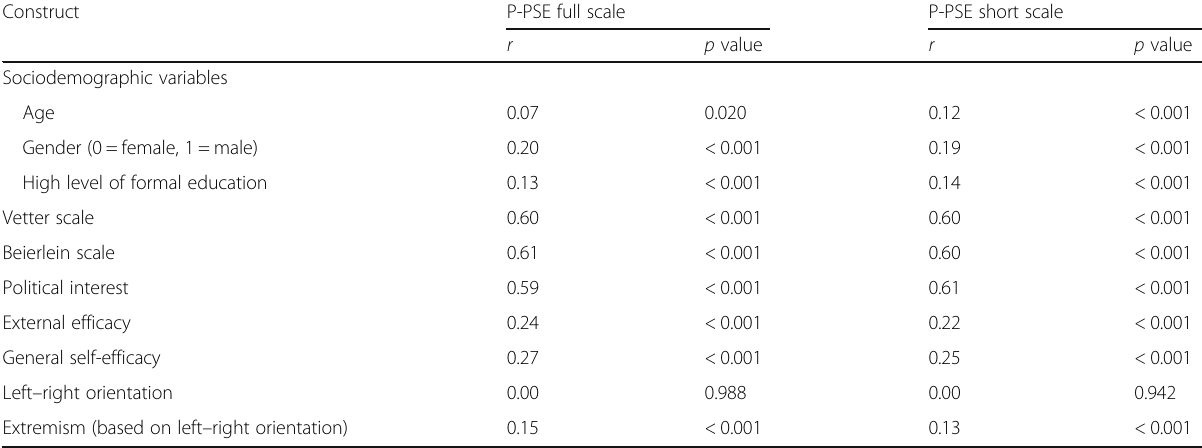
Table 3 Pearson ’ s correlations of the P-PSE scales with theoretically related (convergent validity) and unrelated (discriminant validity)